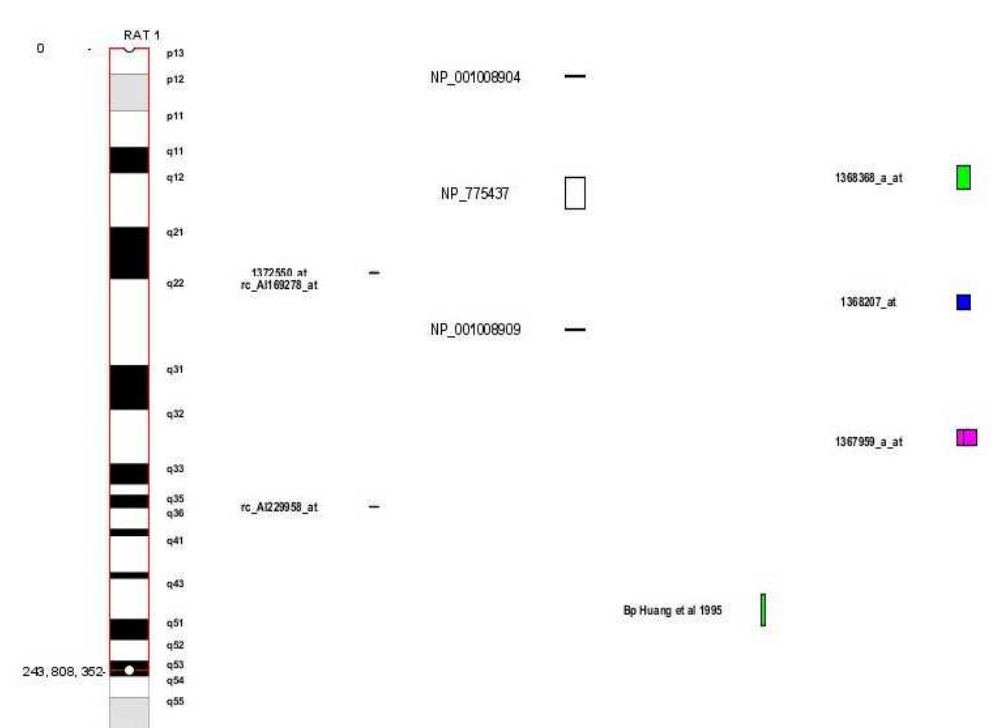
Figure 2: Visualisation of integrated data in VisGenome. Rat chromosome 1 is shown, and left to right: microarray probes and genes; further to the right, in colour: QTLs and experimental results added from other